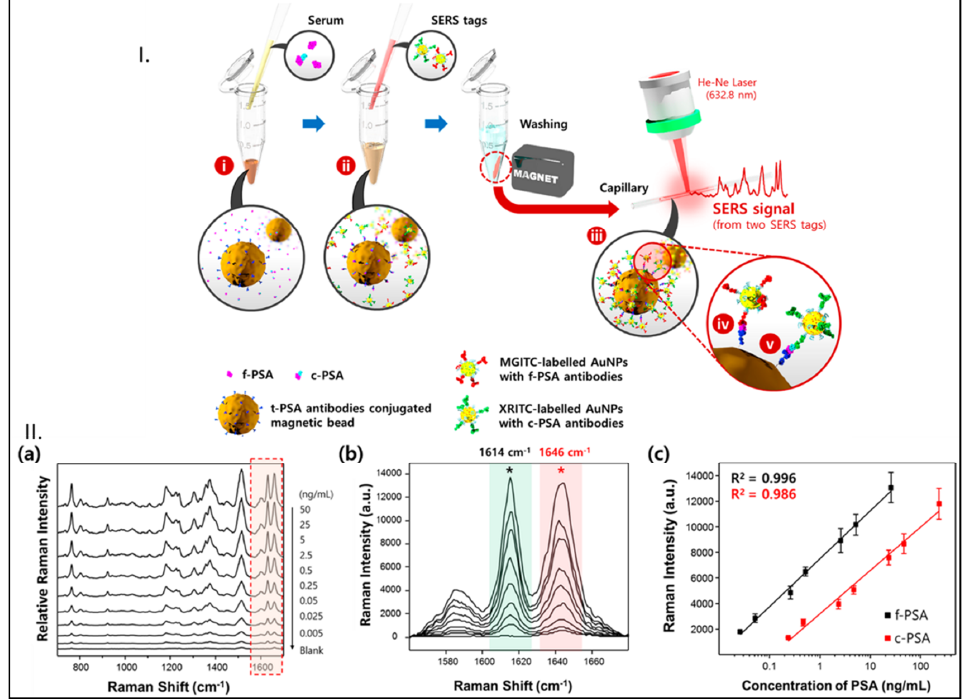
Figure 2. ( I ) Schematic illustration of SERS immunoassay approach for multiplex detection.